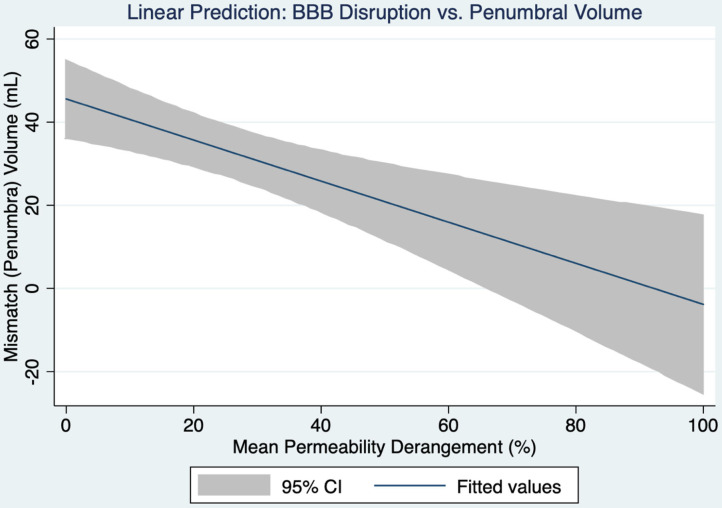
A linear prediction model for the relationship between blood-brain barrier disruption and the volume of penumbral tissue is shown with 95% confidence intervals.